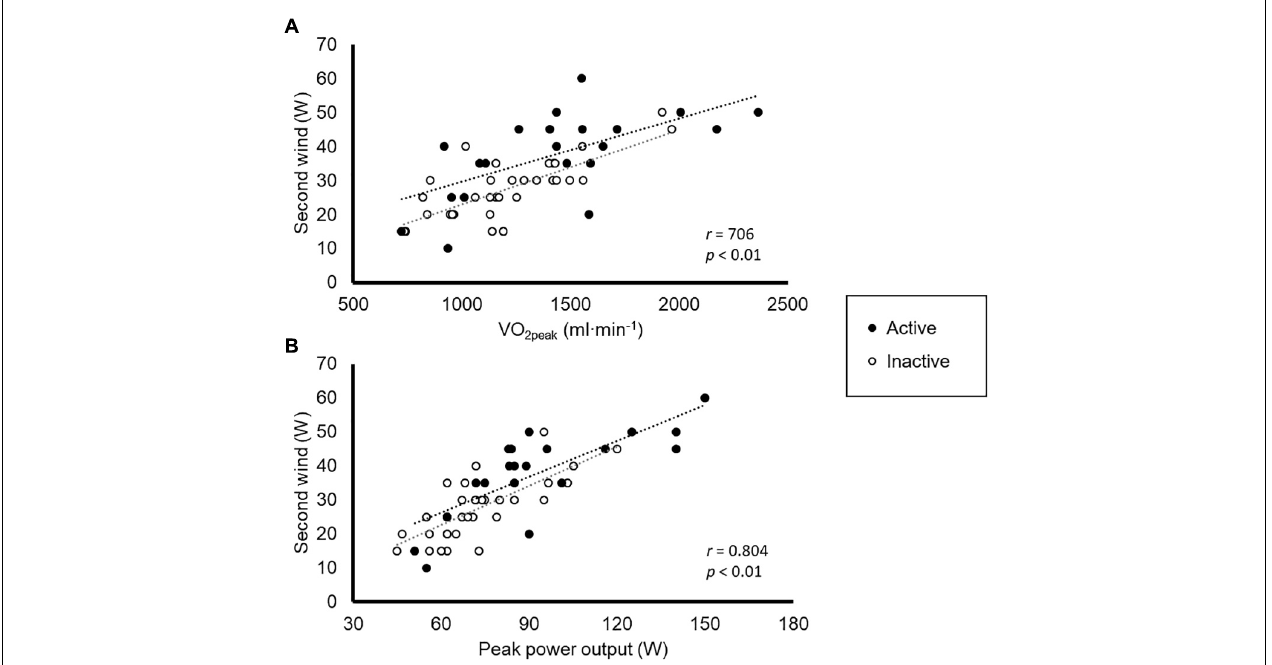
FIGURE 2 | Correlation between peak oxygen uptake (VO 2peak , A ) and peak workload (B) attained by the patients during the ramp-like tests and the minimum workload eliciting the second wind phenomenon.